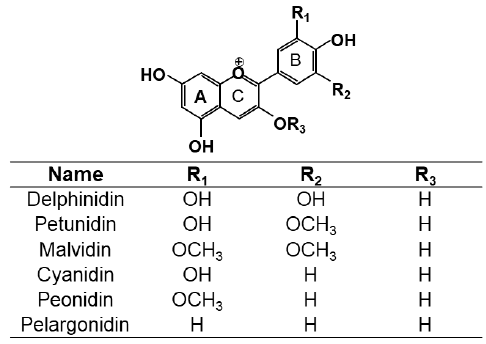
Figure 1. Structure of anthocyanins R 3 = sugar, and anthocyanidins R 3 = H.